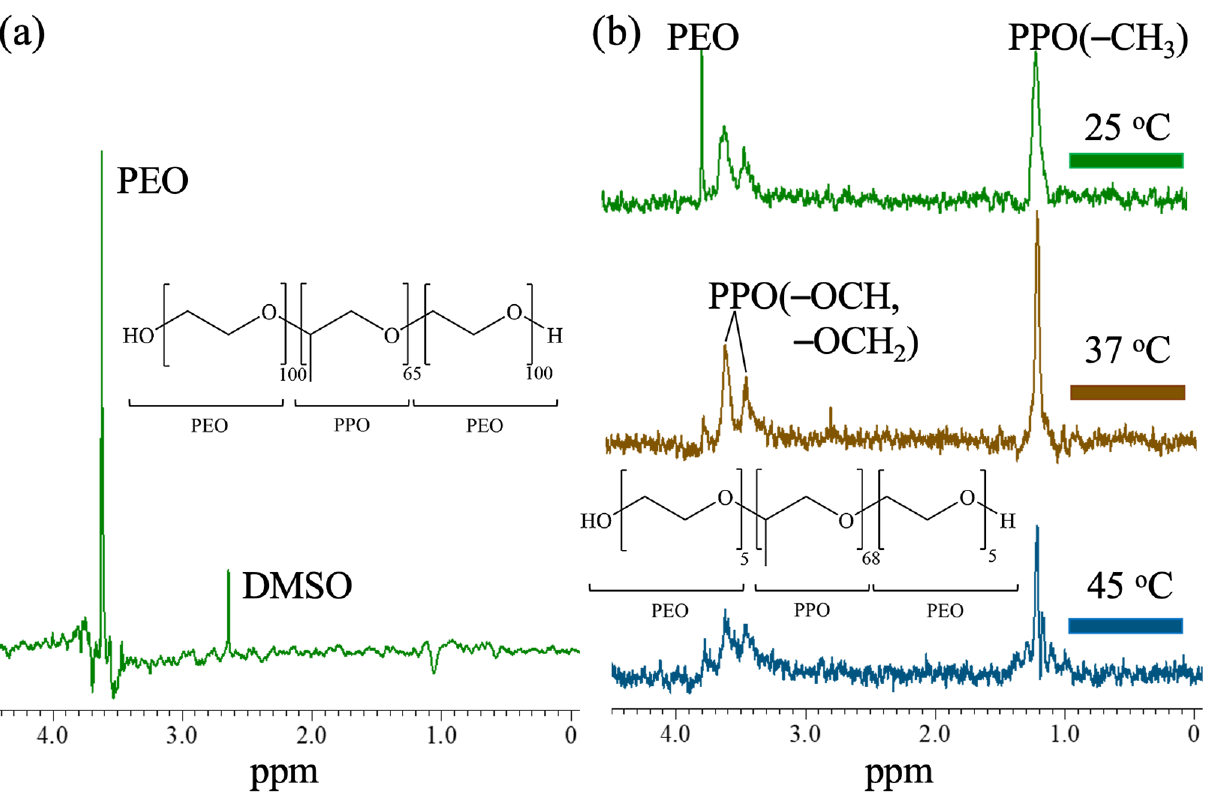
Figure 2. ( a ) HOESY of 5-FU embedded in F127 at 25 ◦ C. ( b ) HOESY of 5-FU embedded in L121 at 25 ◦ C, 37 ◦ C, and 45 ◦ C. The same measurement protocols of HOESY are reported in Figure 3, in order to observe the distribution of the 5-FU medicine in the F127/L121 Pluronic composites at 25 ◦ C, 37 ◦ C, and 45 ◦ C. At 25 ◦ C, although the F127/L121 Pluronic composite is already in the micelle state, the 5-FU medicine is distributed in both the hydrophilic and hydrophobic segments. When the temperature was raised to 37 ◦ C, the hydrophilic PEO segment and the hydrophobic PPO segment signals can both be observed within the resonance energy transfer range of 6 Å of the fluorine atom. The difference is the deteriorated signal of the PEO segment at 3.7 ppm. Among them, for the measurement performed at 45 ◦ C, the 5-FU medicine was mainly at the hydrophobic PPO segment, except for a barely observable signal from the PEO segment that was detected due to the signal around the copolymer junction point. Previous studies demonstrated that the amphiphilic nature of the Pluronic block copolymers would self-assemble into micellization in aqueous solutions above the critical micelle concentration (CMC) and the critical micelle temperature (CMT) [11,29]. Obviously, the stable micellization at a fixed concentration occurs above the CMT, and it becomes a driving force for the migration of the 5-FU medicine leaving away from the hydrophilic PEO segment in the self-assembly. Despite the fact the HOESY experiments were performed at ascending temperatures, the kinetics for the migration of the 5-FU medicine or the reversible process in short-term and long-term stability issues, which influence their shelf life, handling, and storage conditions, should be investigated in the future. The established 5-FU/F127/L121 Pluronic blending composites have a micelle structure that acts as a microenvironment mimicking the cell function to uptake or expel the 5-FU medicine by an external